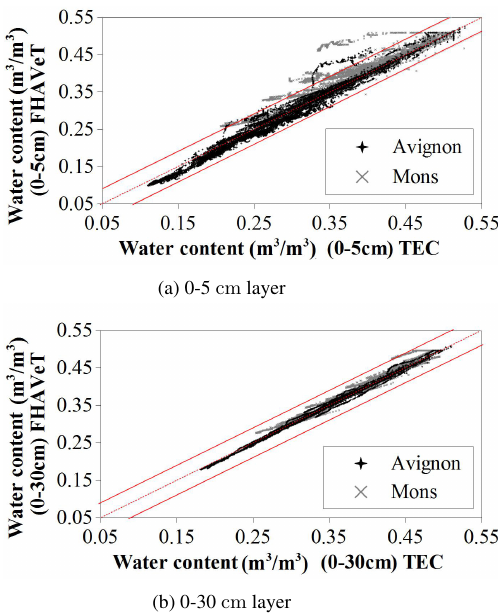
Figure 4. Comparison of soil water content between models FHAVeT and TEC for all models every